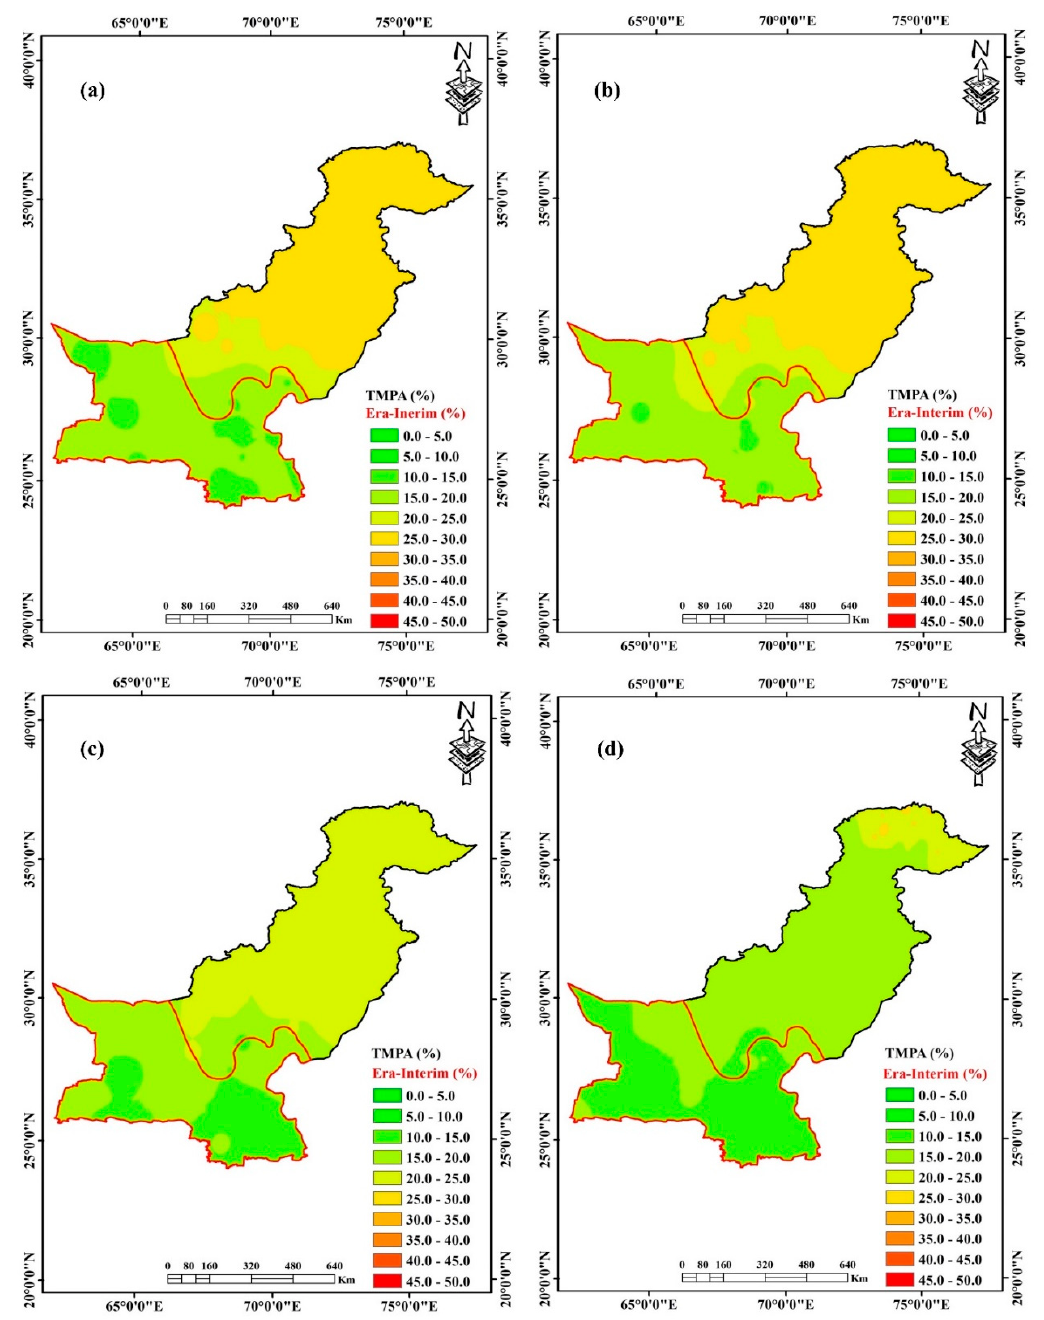
Figure 5. Spatial distribution of average Tropical Rainfall Measurement Mission (TRMM) Multi-Satellite Precipitation Analysis (TMPA) and ERA-Interim (reanalysis dataset) seasonal weights, across Pakistan from 2007 to 2018. ( a ) Pre-monsoon; ( b ) Monsoon; ( c ) Post-monsoon; ( d ) Winter. The seasonal distribution of TMPA in combination with ERA-Interim (hyper-arid region marked with red boundary) are presented in Figure 5. Similar to IMERG, TMPA dominated the pre-monsoon and monsoon seasons, while relatively poor weights were depicted during post-monsoon and winter seasons. The average weights of TMPA during the pre-monsoon and monsoon seasons are 26.24% and 27.92%, respectively. The maximum (28.36%) weight for TMPA is observed during the monsoon season across the glacial region, while the minimum (17.40%) weight is observed during the winter season across the humid region. The average weights of ERA-Interim in the hyper-arid region